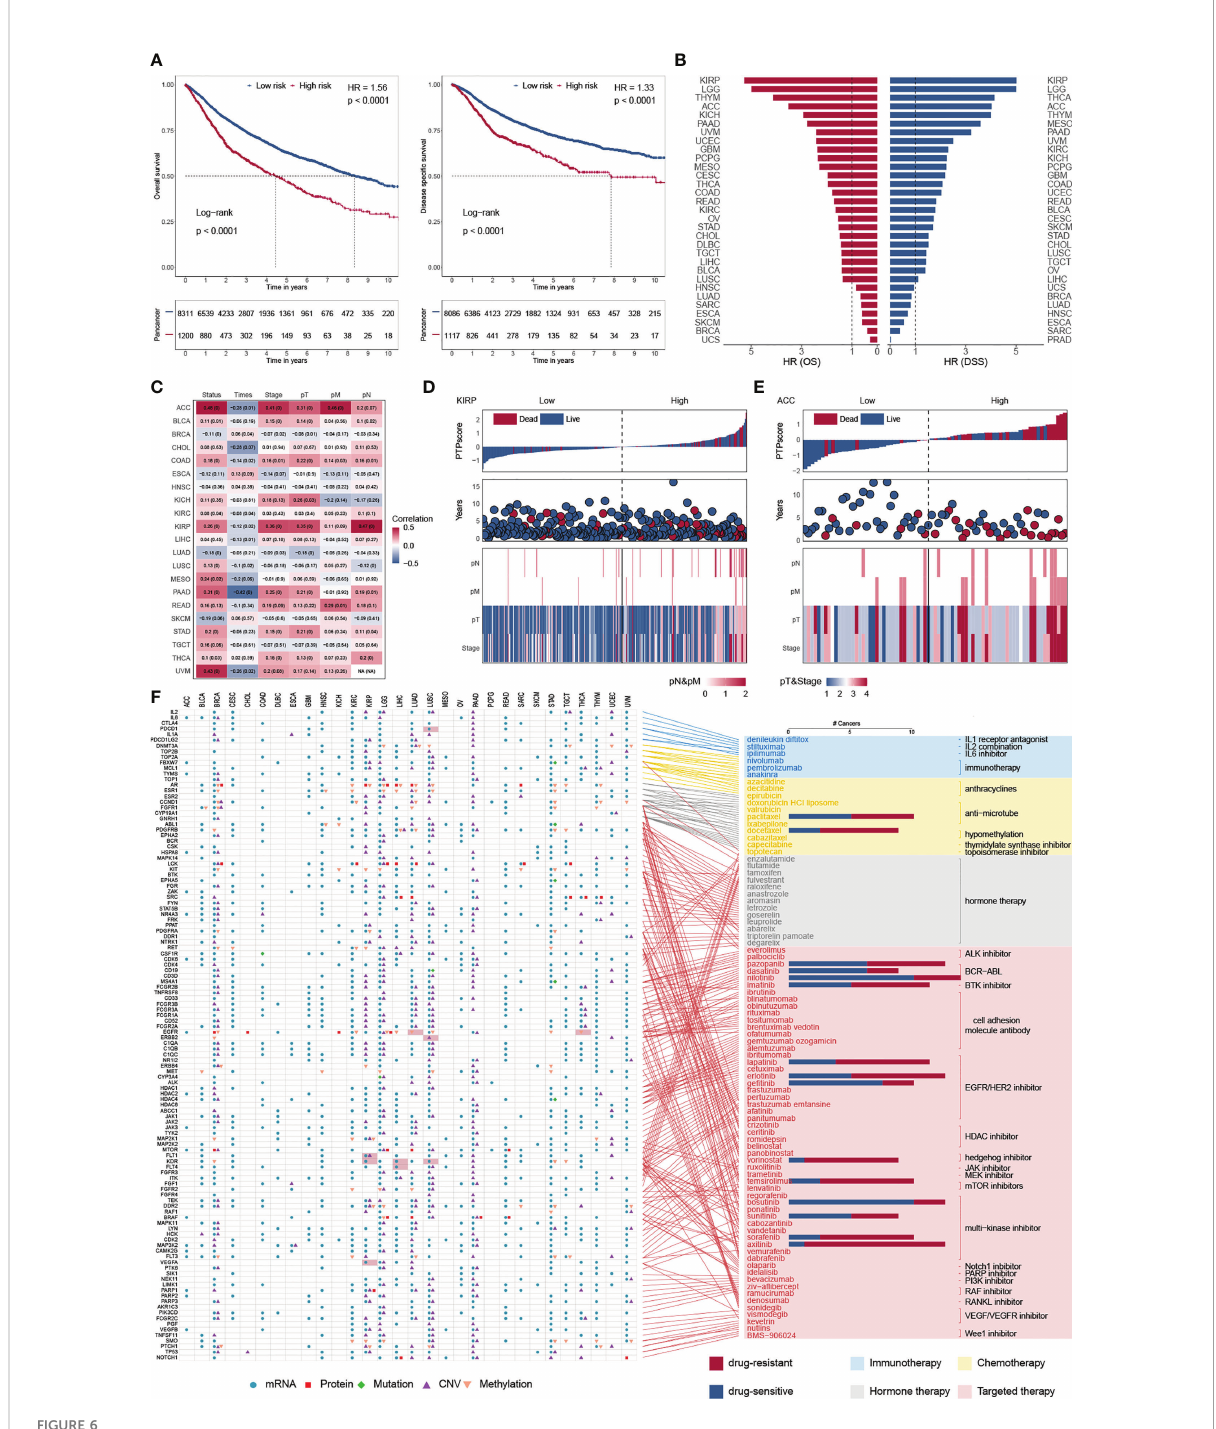
FIGURE 6 Predictive ability of PTPscore across cancers. (A) Kaplan – Meier plot showing the 10-year OS (left) and PFS (right) for PTPscore in pan-cancer. (B) The HR of OS and DSS for PTPscore in different cancer. (C) Correlation between PTPscore and AJCC stage. (D, E) PTPscore predicted values distribution with patient survival status (top), survival years (middle), and AJCC TNM staging status (bottom) for KIRP and ACC. (F) Association between FDA-approved drugs and their linked CAGs (right) and alterations of these genes at mRNA, protein, DNA methylation, mutation, and SCNA levels based on PTPscore across cancers (left). Different symbol shapes indicate various types of molecular signatures. Filled cells suggest that the gene is a therapeutic target of clinical practice in the corresponding cancer type. Bar plots in the right panel indicate the number of cancer types with a positive correlation (drug-sensitive, blue) and negative correlation (drug-resistant, red) between PTPscore and drug response (Spearman ’ s